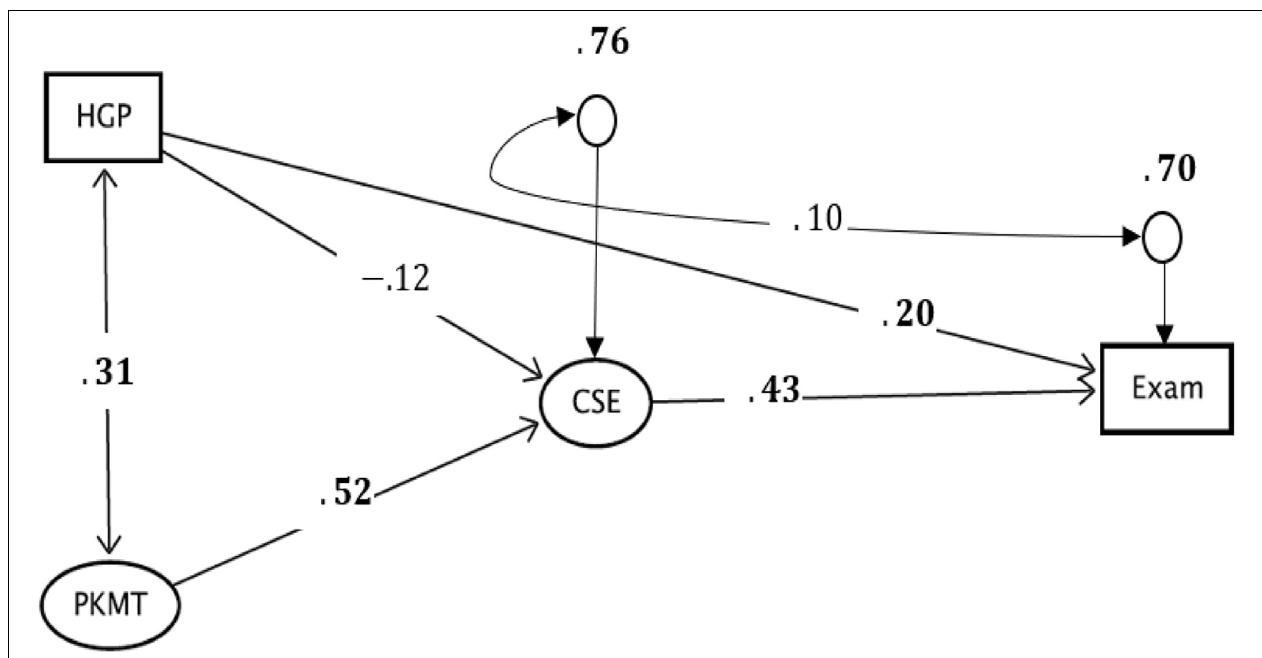
FIGURE 2 | The evaluated model of the relationship between prior mathematics knowledge, self-efficacy, and students’ performance in an introductory calculus course. Both HGP and PKMT are measures of the prior mathematics knowledge of the students, CSE is a measure of the self-efficacy, and Exam represents a measure of performance. The significant estimates are in bold faces, and the items of both PKMT and CSE are not included in Figure 1 to enhance the readability of the figure. The full figure that contains all the items and the associated model parameters is available in Appendix Figure A1